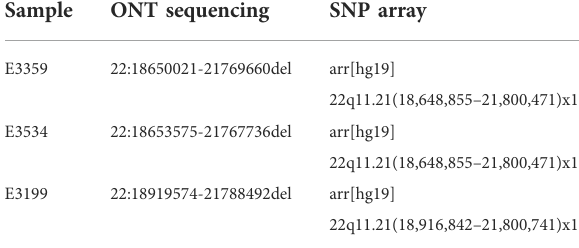
TABLE 2 Results of structural variation